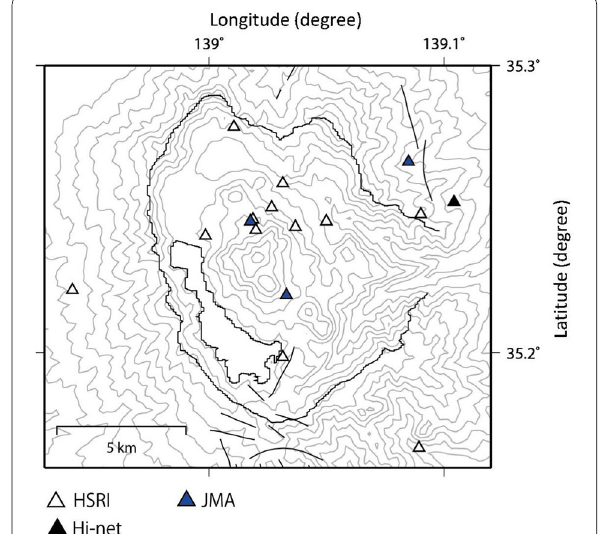
Fig. 1 Map of station location used to create learning data set. Open triangle is the stations operated by Hot Spring Research Institute. Closed triangles are those operated by JMA and